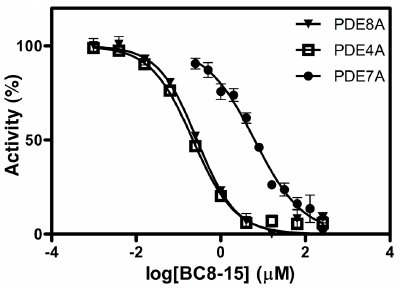
Figure 2. Inhibition of PDE4A, PDE7A and PDE8A by BC8-15 as determined by invitro enzyme assays. BC8-15 inhibitory activity was measured by in vitro PDE assays as described in Materials and Methods. Substrate concentrations are 10 nM cAMP for PDE8A and PDE7A and 50 nM cAMP for PDE4A. Each assay was performed at 10 different compound concentrations in duplicate reaction tubes. IC 50 6 SD values are determined by performing non-linear regression analysis on three independent